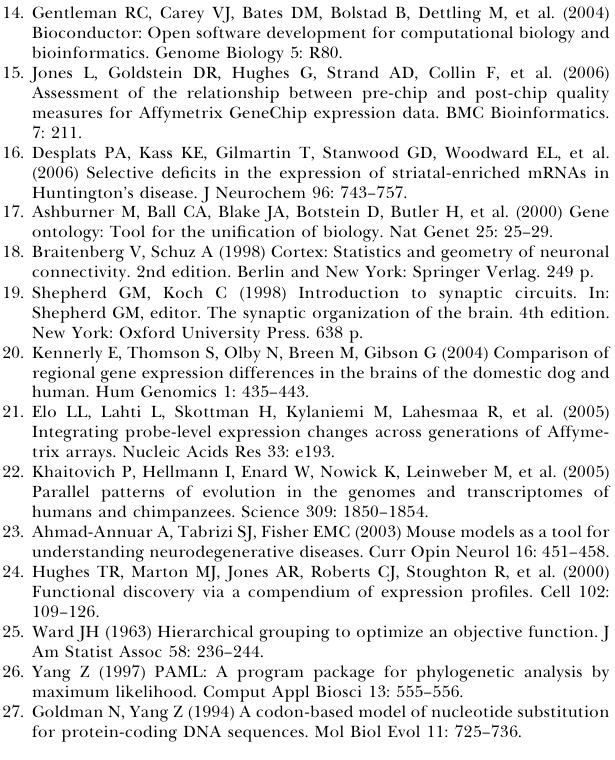
Table S1. Key Relating GEO Accession Numbers, Clinical Covariates, and Samples Table S2. Striatal Genes Listed in [16] Found at doi:10.1371/journal.pgen.0030059.st002 (34 KB XLS). Table S3. GO Categories Common to Human and Mouse Brain Regions Found at doi:10.1371/journal.pgen.0030059.st003 (59 KB XLS). Table S4. Observed and Expected Numbers of GO Categories Reaching Various p -Value Thresholds and p , 0.05 False Discovery Rates